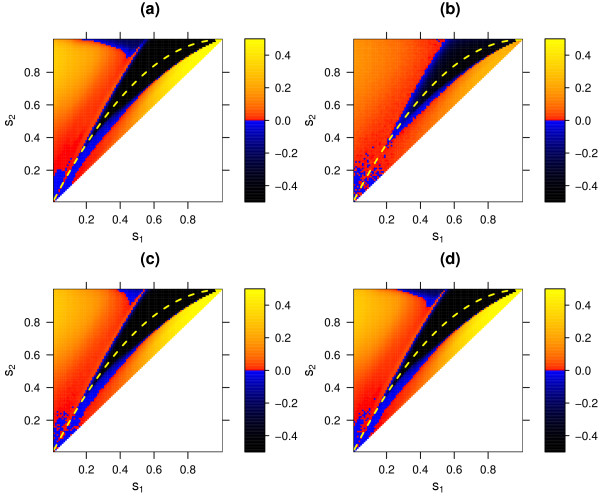
Selective advantage of a modifier increasing the recombination rate in the standard model(rmm = 0.1, rmM = 0.15, rMM = 0.2), for the deterministic regime (a) and for the stochastic regime with population size N = 1000 (b), N = 10 000 (c), and N = 100 000 (d). For further details see legend of figure 5.